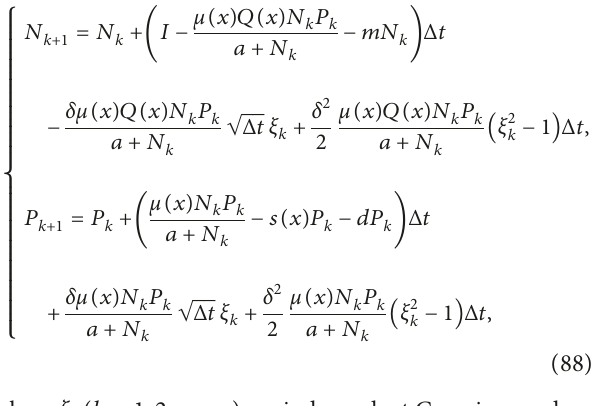
Figure 2: (a–c) Bifurcation diagram of nutrient in model (1) with respect to x ∈ H model (1) with respect to x ∈ H . (a) and (d) for x ∈ ( 0 . 07807216867 , 0 . 1 ] . (b) and (e) for x ∈ ( 0 . 1 , 0 . 6 ] . (c) and (f) for 2 x ∈ ( 0 . 6 , 2 . 981219088 )